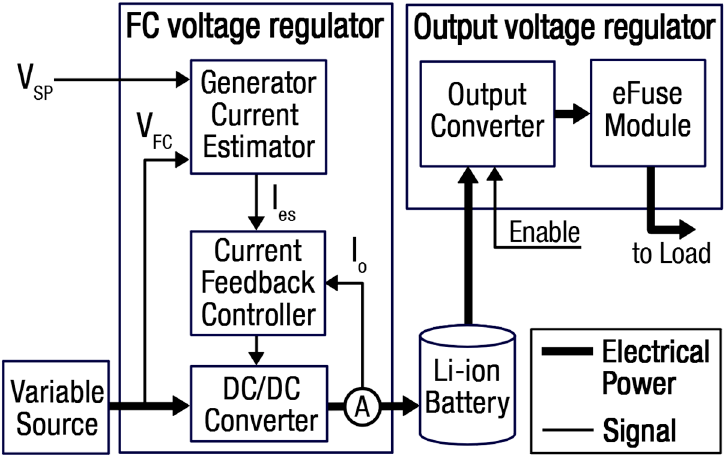
Figure 4. The fuel-cell (FC) voltage regulator and the output voltage regulator block diagram.